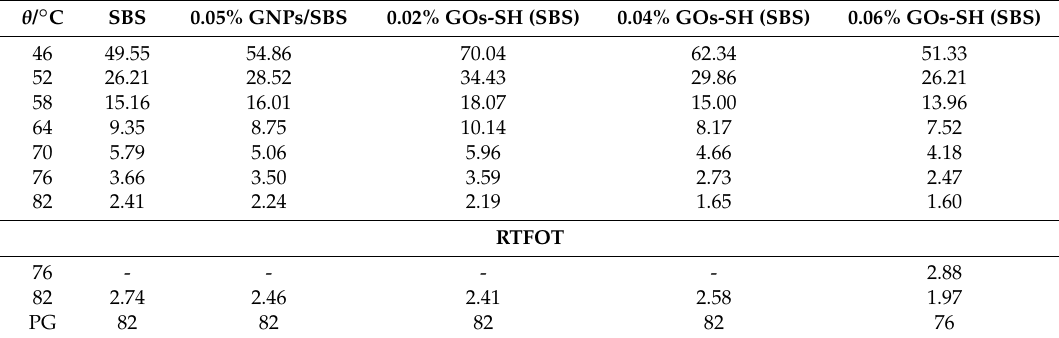
Table 1. RF (kPa) of each sample as a function of